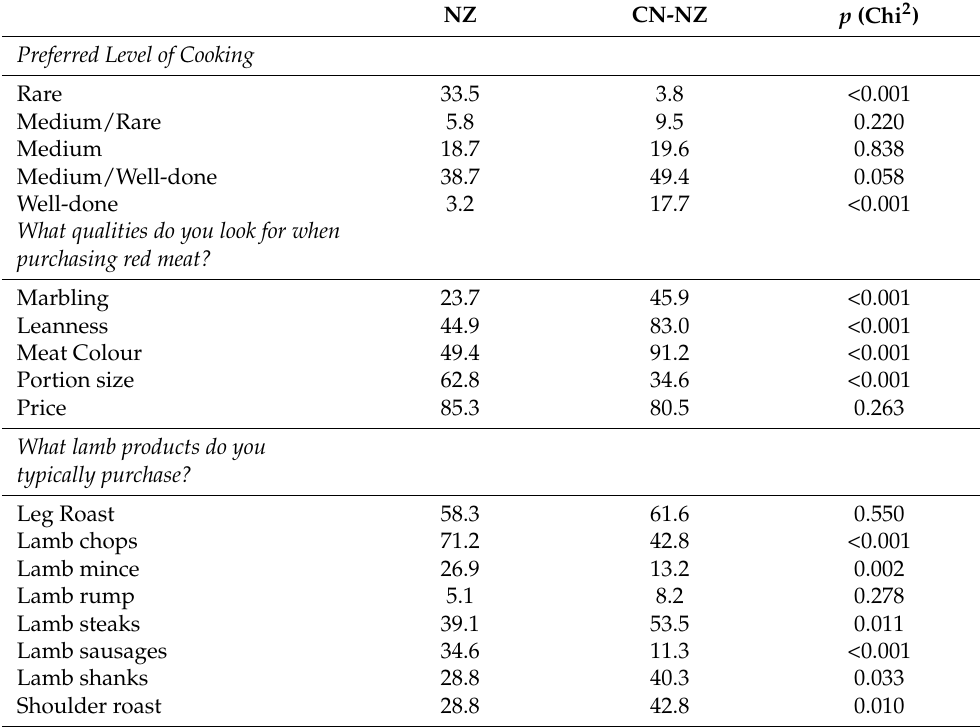
Table 3. Preferred level of cooking, meat qualities of interest to consumers at the point of purchase and purchase frequency of different lamb products (%) ( p value determined using a Fishers exact test (Chi-squared) for